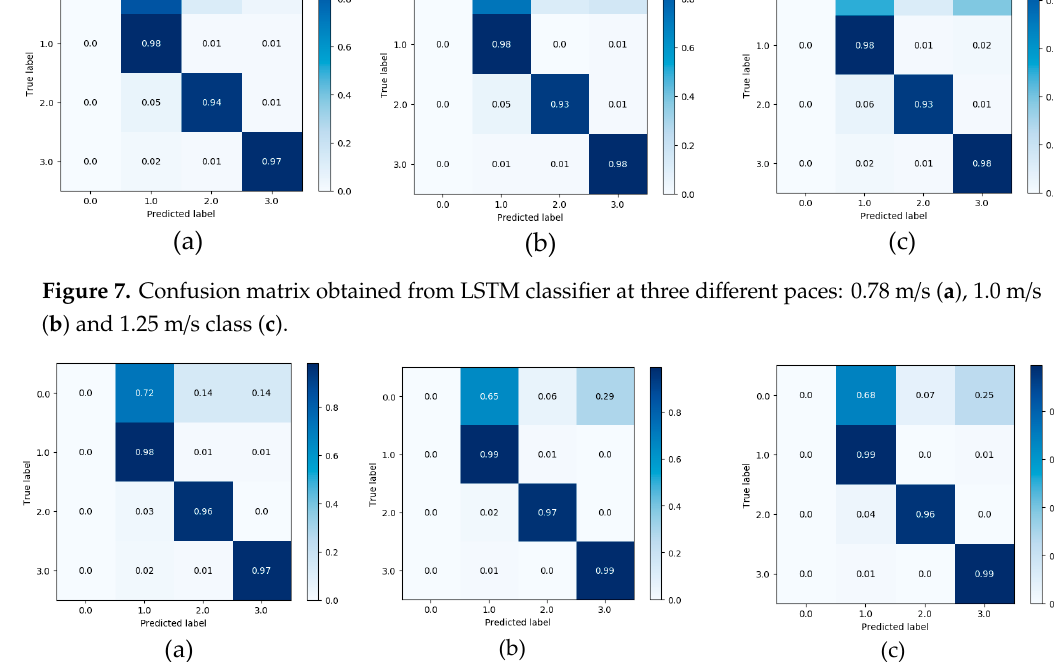
Figure 8. Confusion matrix obtained from LSTM+CNN classifier at three different paces: 0.78 m/s ( a ), 1.0 m/s ( b ) and 1.25 m/s class ( c ).